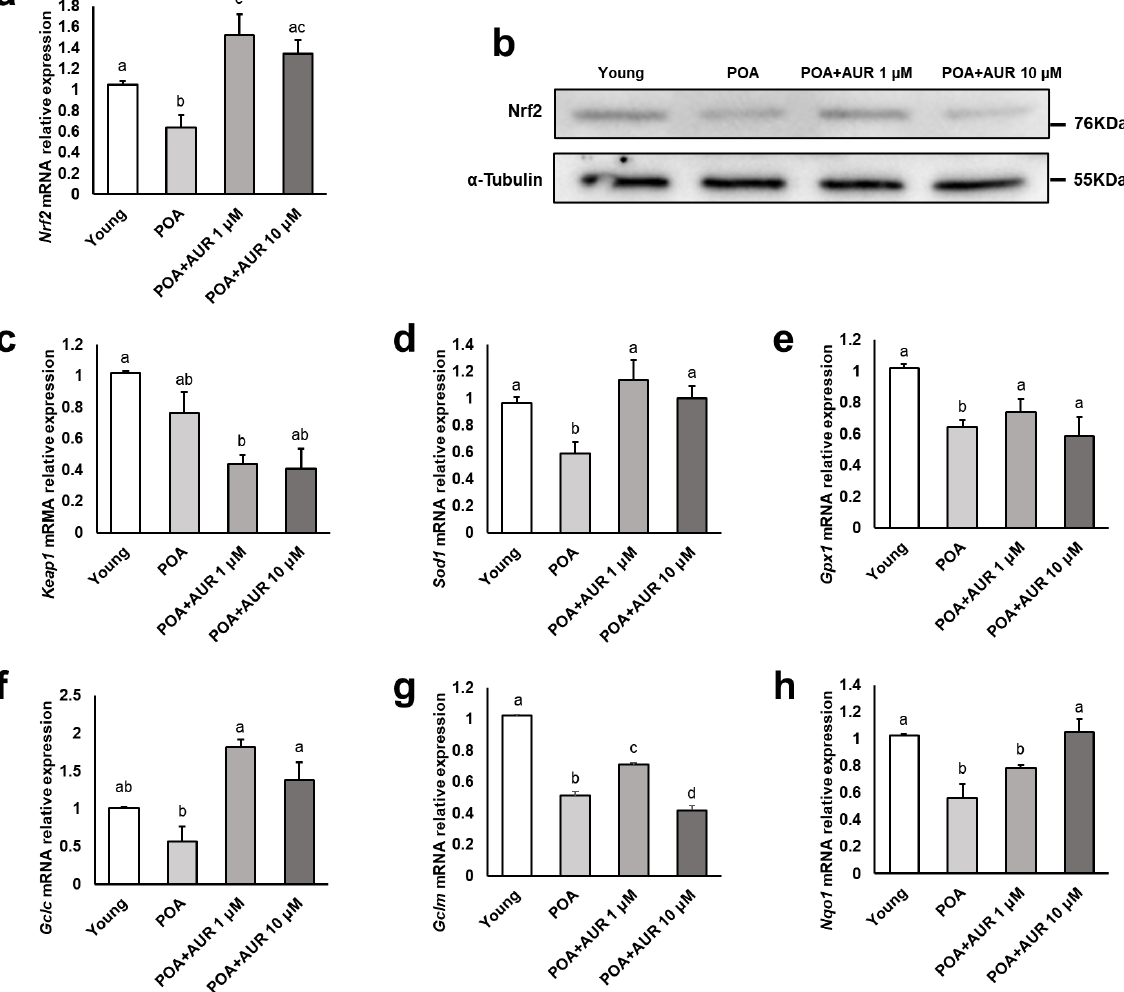
Figure 5. AUR upregulated the expression of NRF2-related genes during postovulatory aging. ( a , b ) Expression patterns of NRF2 mRNA and protein in postovulatory aged oocytes. ( c – h ) Transcription levels of NRF2-related genes ( Keap1 , Gclc , Gclm , Gpx1 , Sod1 and Nqo1 ), p < 0.05. Data are presented as the means ± SEMs of at least three independent experiments. Significant difference indicated by lowercase letters of the alphabet, p < 0.05.